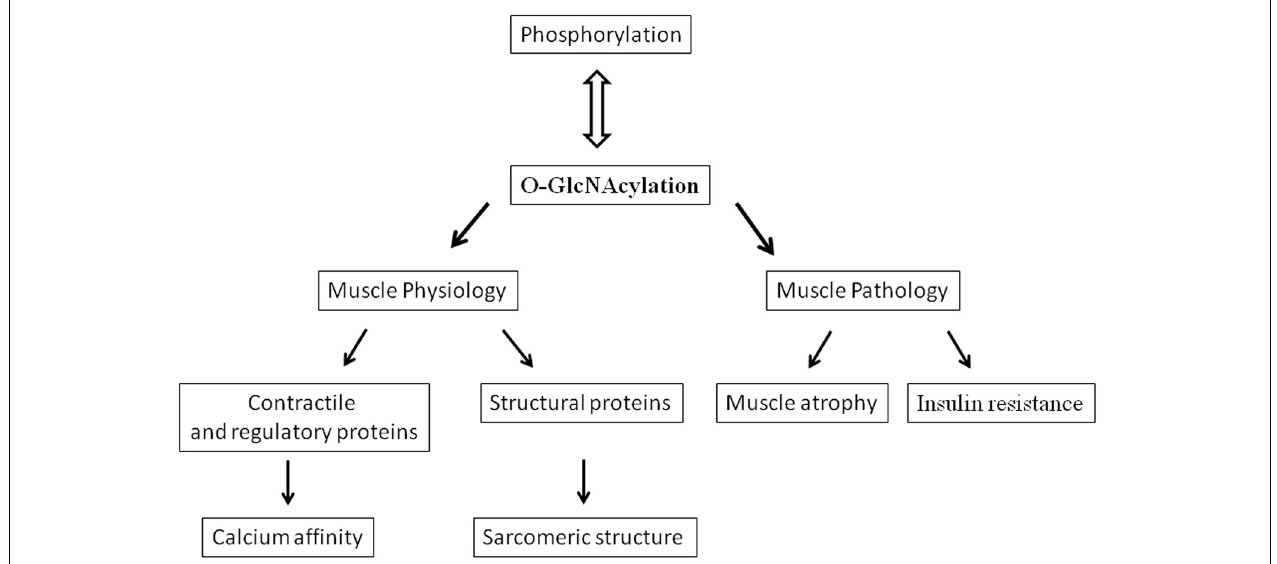
FIGURE 1 | Diagram showing various effects and implications of O-GlcNAcylation in skeletal